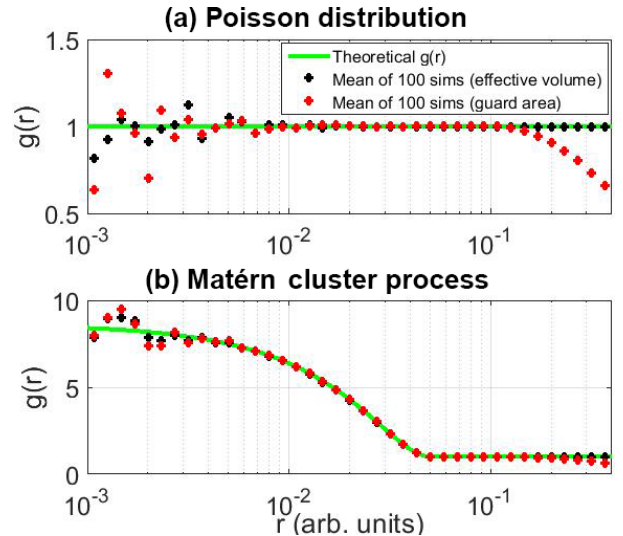
Figure 3. First verification of the method for calculating g(r) de- scribed in the main text. Here, theoretical curves of g(r) are com- pared to both the effective volume method and the guard area method (using a fixed guard area of 0.1 times the side length of the cube). In the top panel, 100 different 10000 particle Poisson dis- tributions were created. Deviations from g(r) = 1 in both methods are observed at small r values due to sampling fluctuations. Panel (b) shows similar results from 100 simulations of a Matérn cluster process (with a mean of 10000 total particles and a cluster length of 0.025). Note that in both panels the guard area approach begins to fail as expected for r > 0 . 1.